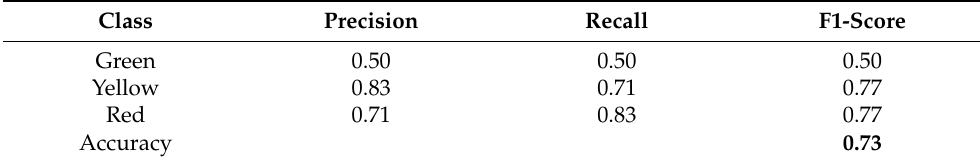
Table 2. Classification report for the GaussianNB classifier.